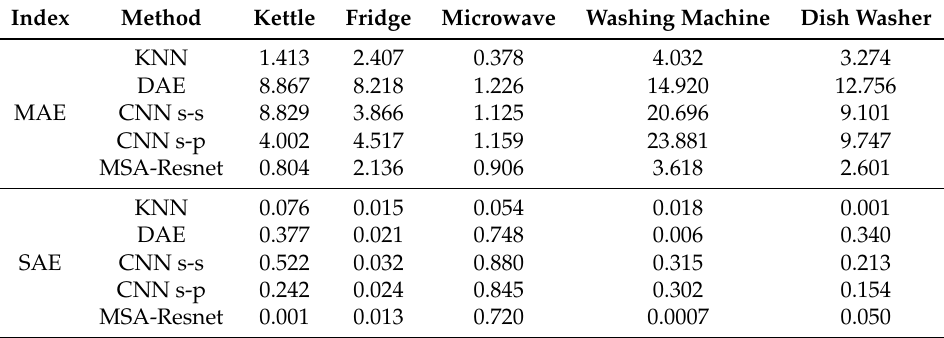
Figure 9. Comparison load disaggregation results of Household 5 in the UK-DALE dataset. Table 4. Comparison of the load disaggregation indexes of Household 5 of the UK-DALE